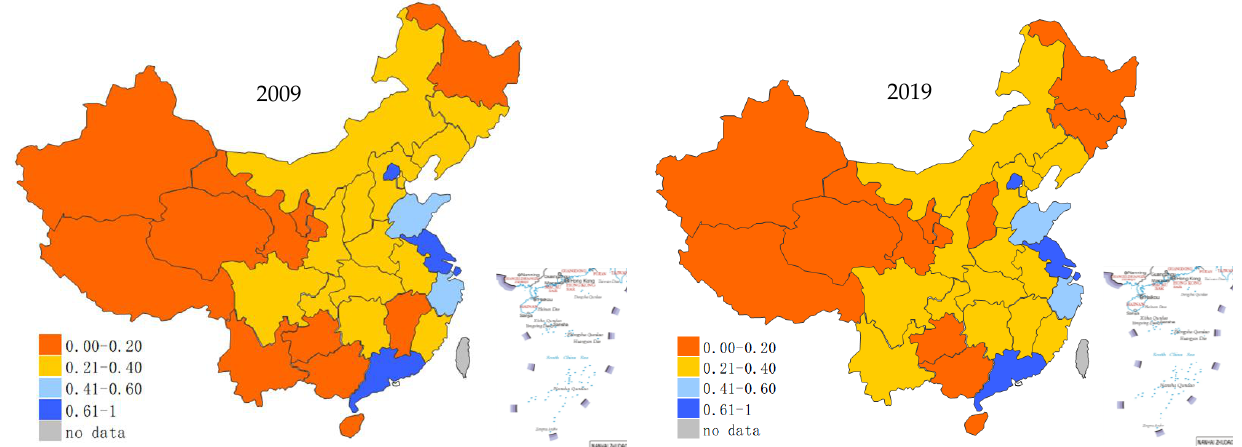
Figure 3. The development level of the regional economy.